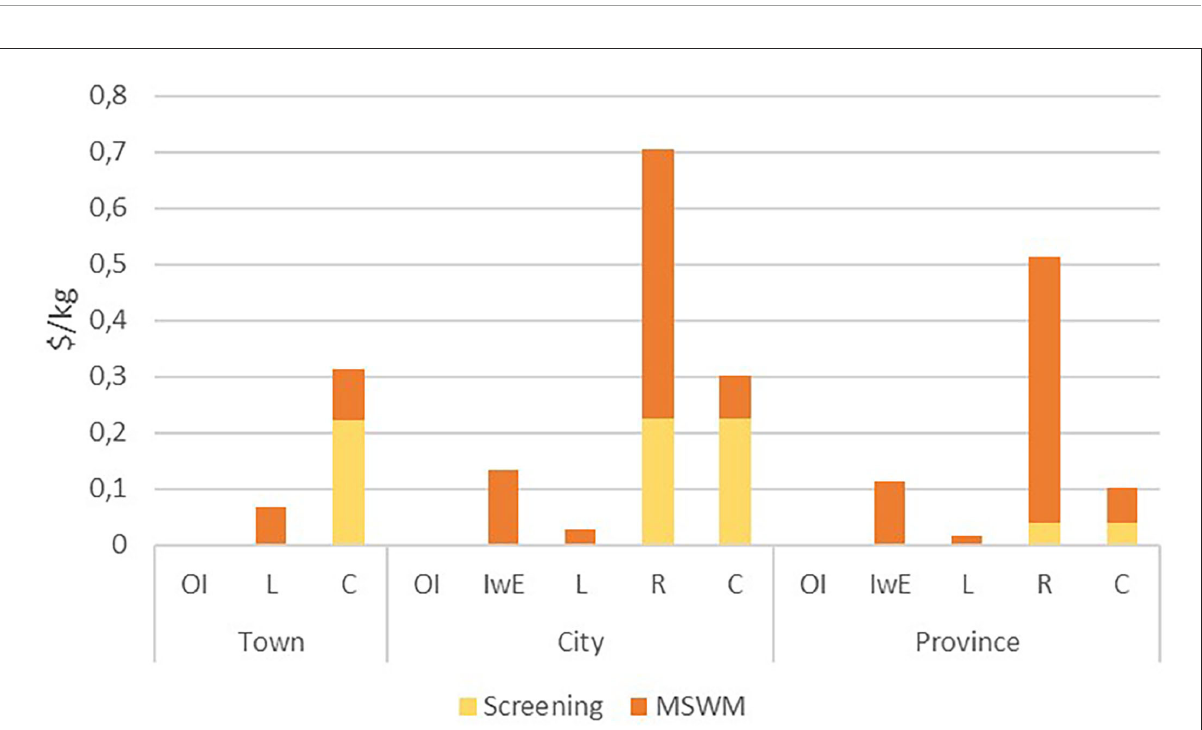
FIGURE4 TEA of solid waste management systems (OI, 100% Open Incineration; IwE, 100% Incineration with energy recovery; L, 100% Landfill; R, 100% Recycling; CP, 100% Composting).